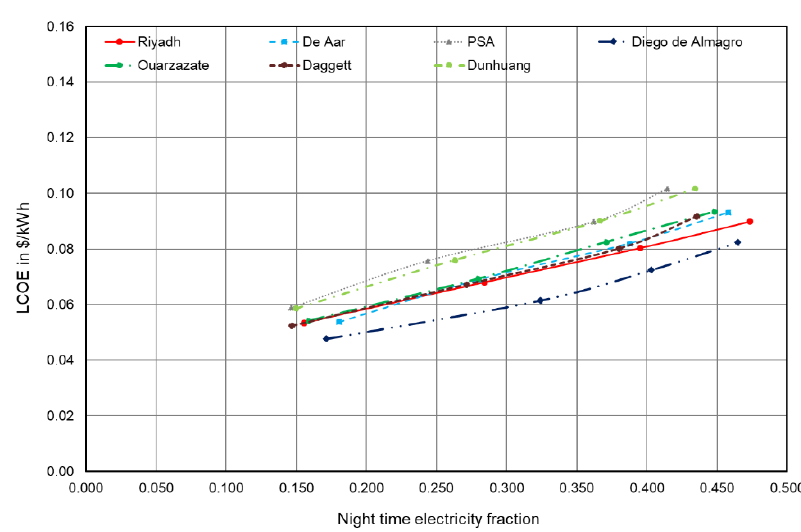
Figure 7. Comparison of locations: trough hybrid.